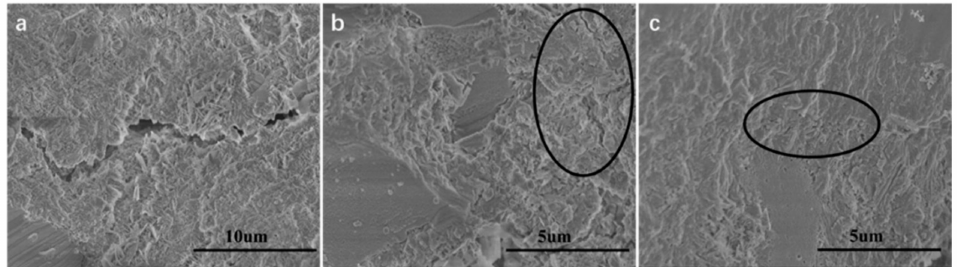
Figure 27. SEM images of the ( a ) plain OWC matrix including a straight-through crack, ( b ) GO / OWC specimen containing fine cracks and ( c ) TEA-GO / OWC specimen. Reprinted with permission from [159]. Copyright © 2019, Elsevier